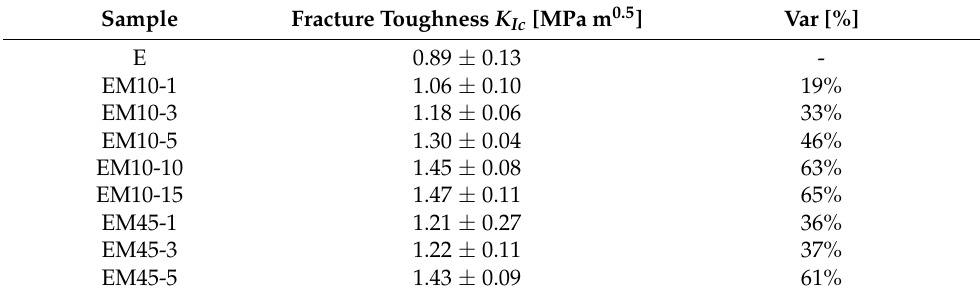
Table 5. Results from fracture tests. Values are reported in terms of mean value and standard deviation. Variation column reports the variation of the mean value with respect to neat